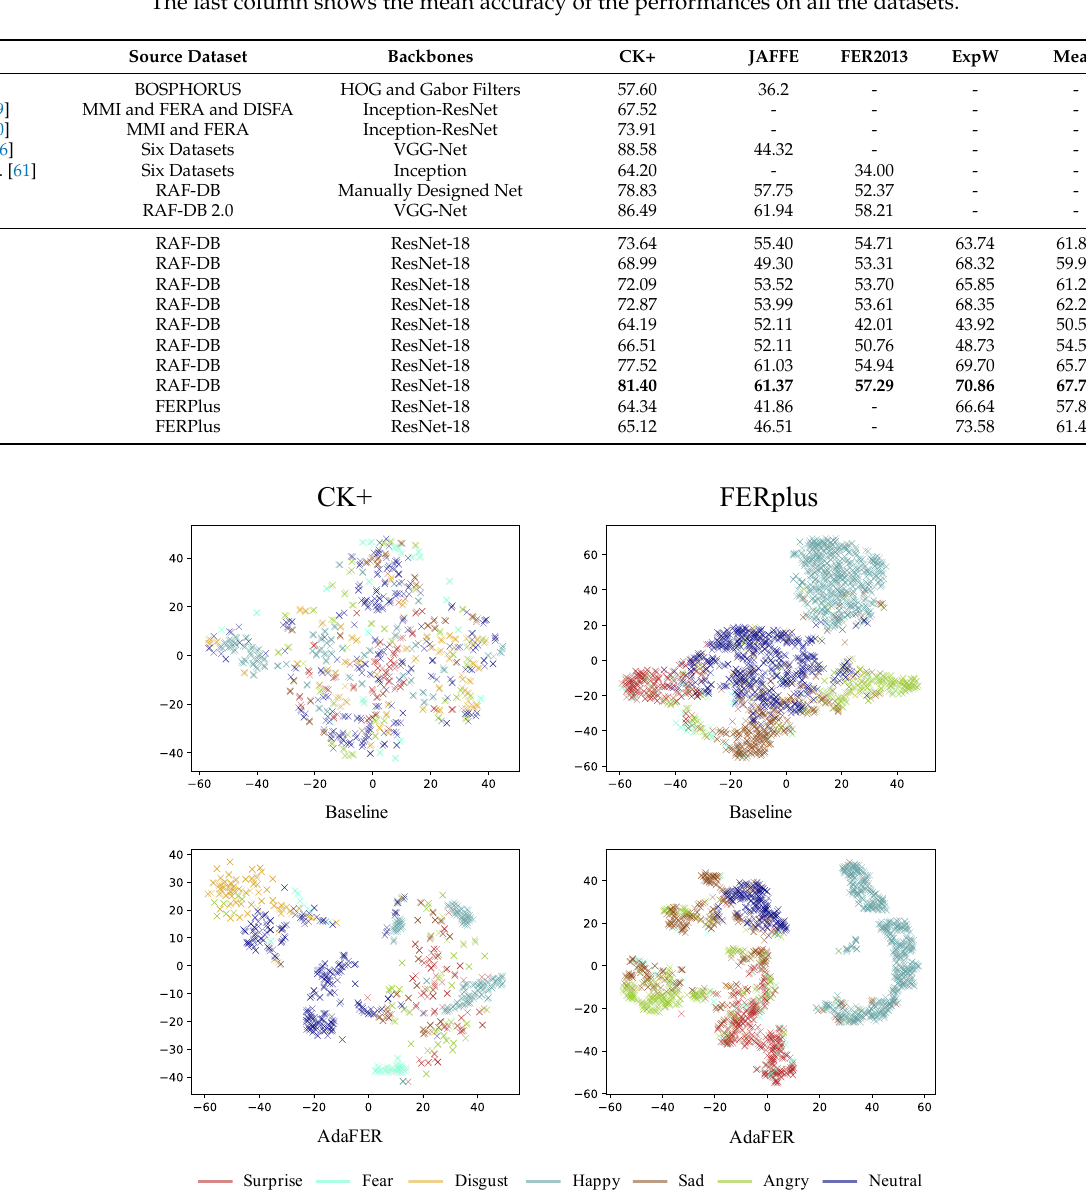
Table 5. Comparison of the state-of-the-art methods on the CK+, JAFFE, FER2013, and ExpW datasets. The results of upper part are taken from the corresponding papers, and the results of the bottom part are taken from the implementation of a cross-domain facial expression recognition benchmark [57]. The last column shows the mean accuracy of the performances on all the datasets.